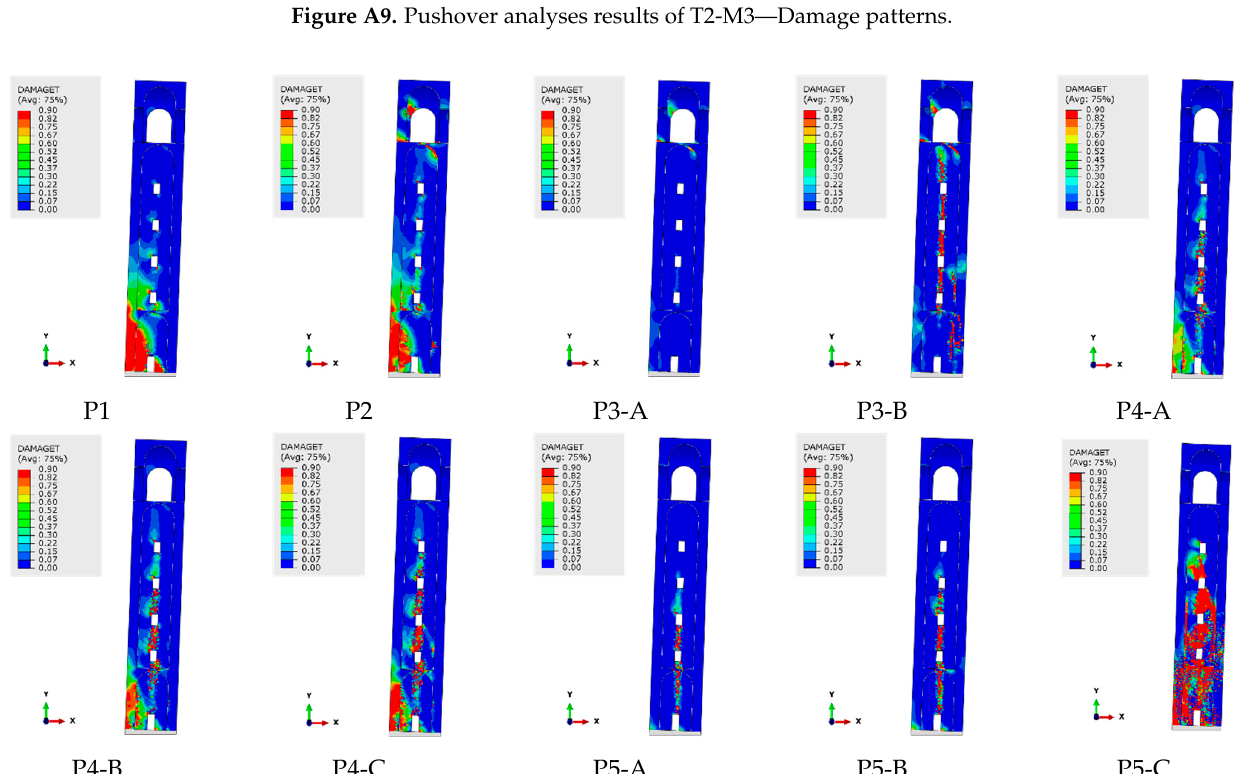
Figure B6. Pushover analyses results of T2-M3—Damage patterns.